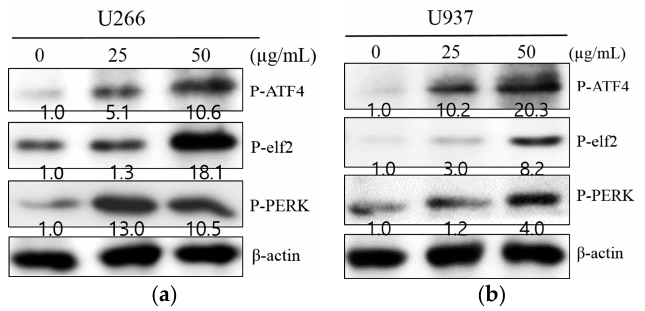
Figure 3. SM induces endoplasmic reticulum (ER) stress-related proteins in U266 and U937 cells. ( a ) U266 cells were treated with SM (25 or 50 µg/mL) for 24 h, and Western blot analysis was assayed for expression of P-PERK, P-eIF2 α , P-ATF4, and β -actin; ( b ) U937 cells were experimented with under the same conditions.